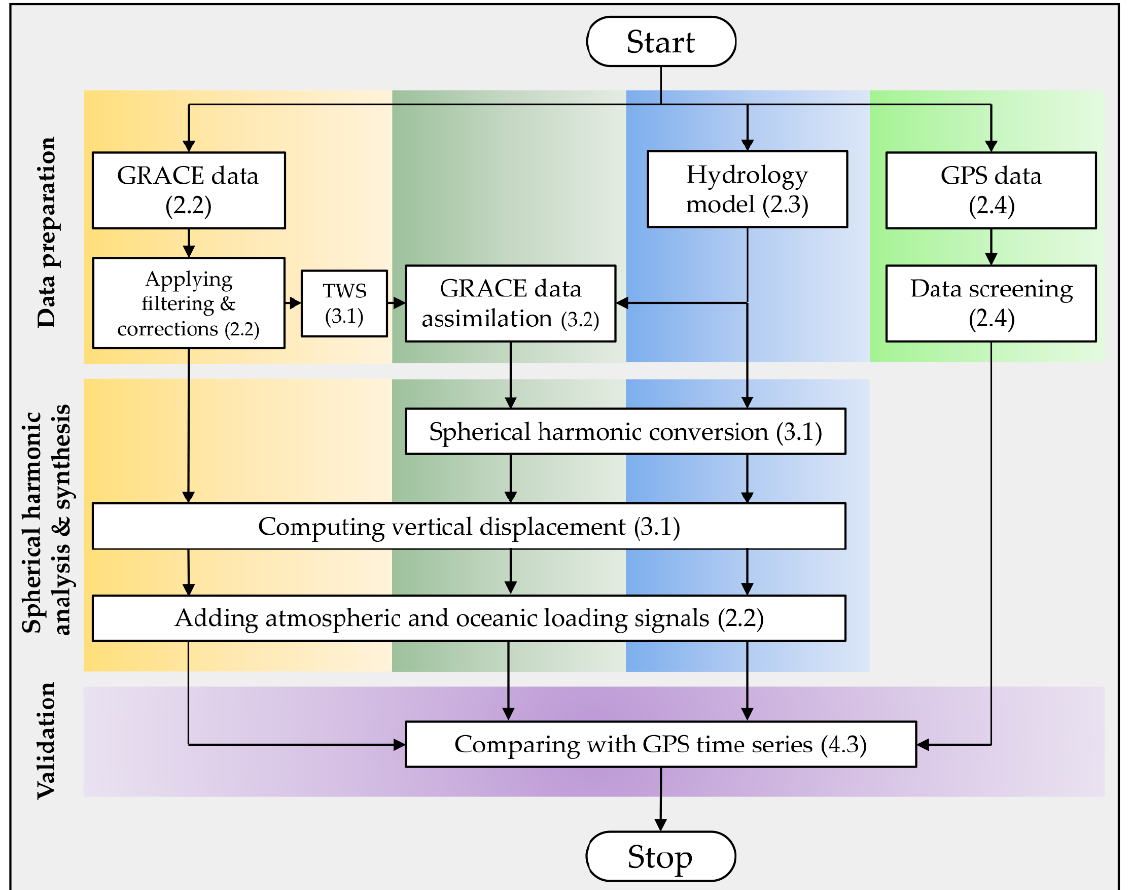
Figure 2. Data processing diagram used in this study. The given number in each processing step indicates the paper’s section where comprehensive details can be found. GRACE: Gravity Recovery and Climate Experiment and TWS: terrestrial water storage.